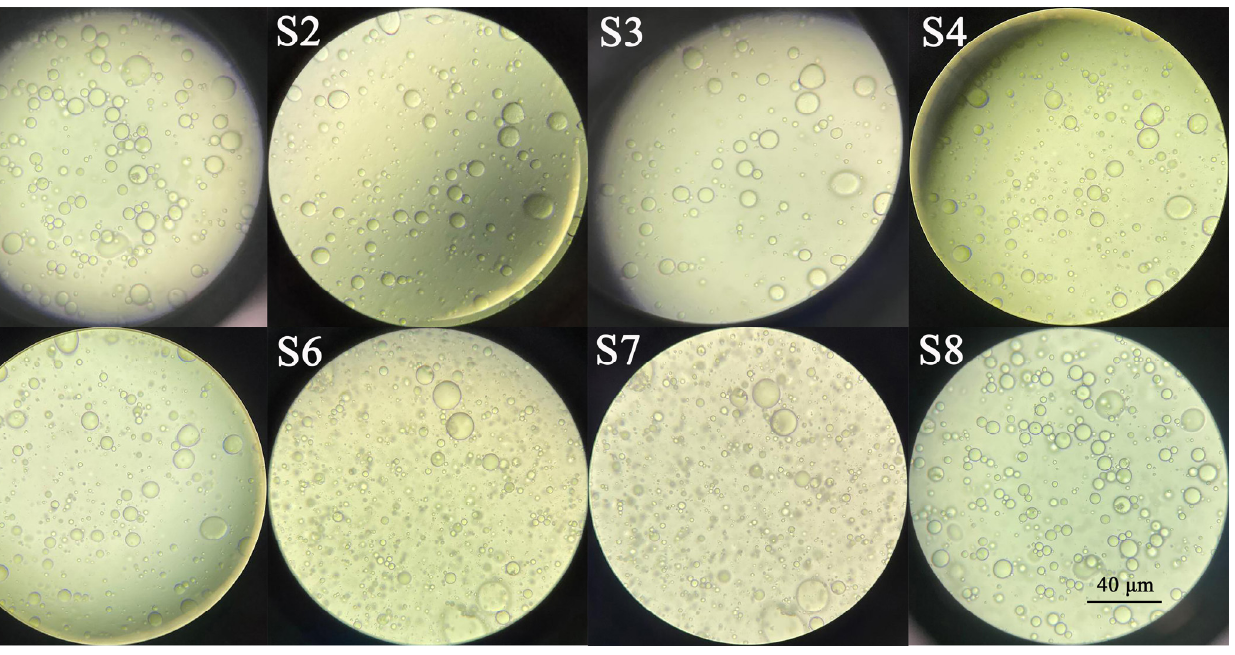
Figure 4. Micrographs of the oil-in-water emulsion formulations observed with an objective magnification of 40×.